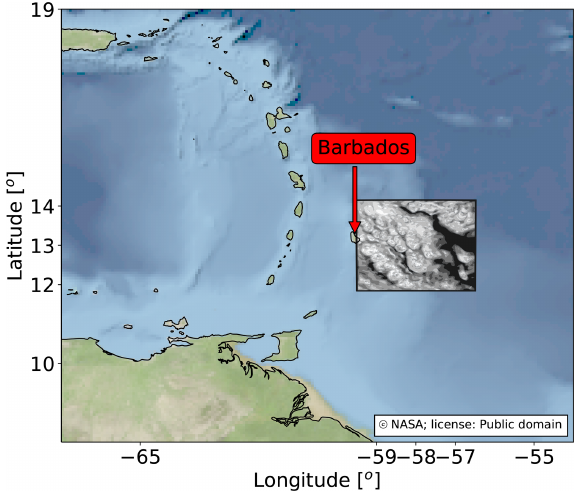
Figure 1. The domain of the simulations (the box in the middle) and the area around it. Inside the domain the average cloud fraction over the first 30min of the simulation for 1 August 2016 is presented; CDNC = 20cm − 3 . The island of Barbados is marked with a red